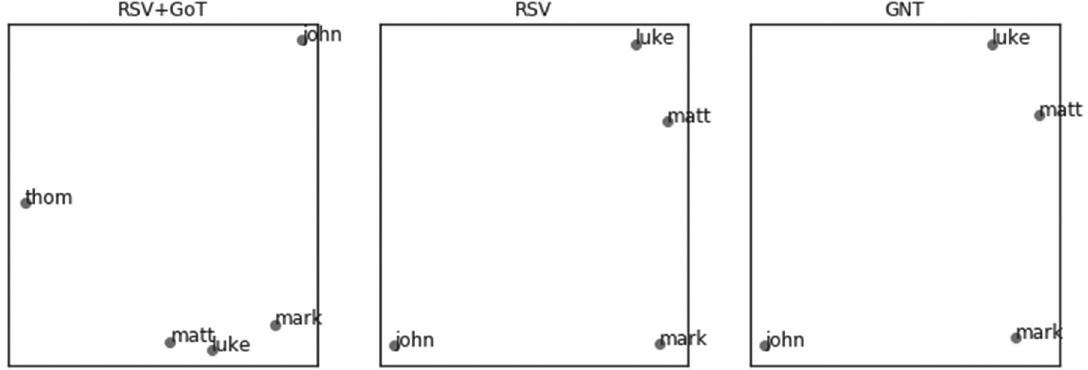
Figure 1: Visualizing distances between canonical Gospels and the Gospel of